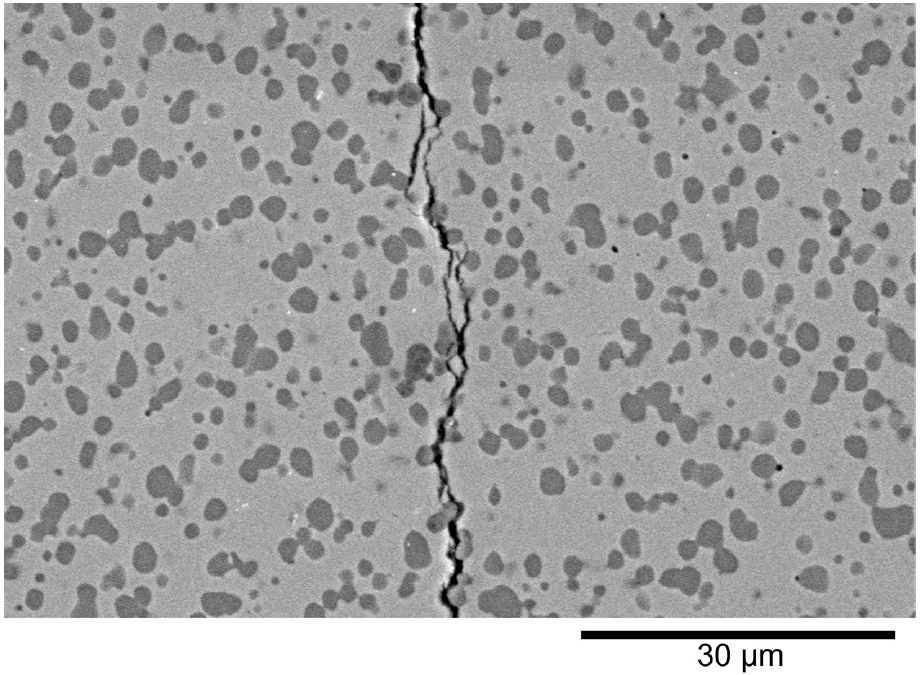
Figure 12. Preferred crack propagation path that occurred through the matrix of the CPM 15V in the PAZ/HAZ of the LF weld.